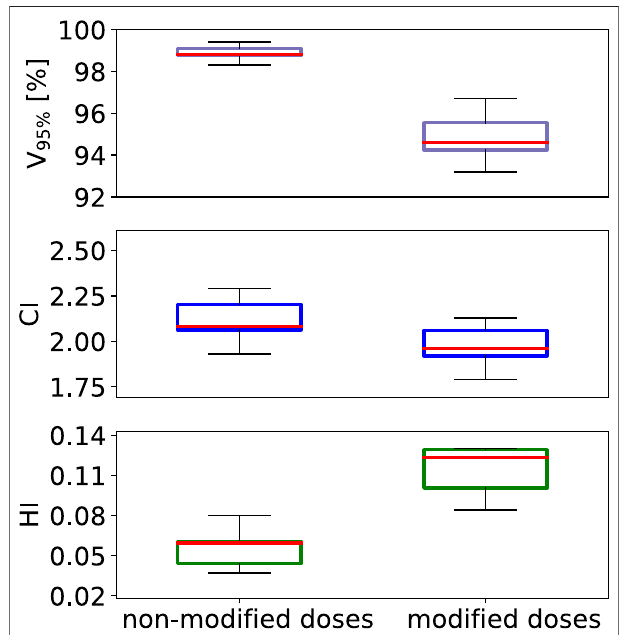
FIGURE 9 | A standard boxplot (median, 1. and 3. quartiles and whiskers including the outliers) for V 95% , HI and CI data sets obtained for patient case P1 using a horizontal beam for non-modulated as well as modulated dose distributions for carbon ions. A set of variable planning parameters was used as given in the materials and method section.